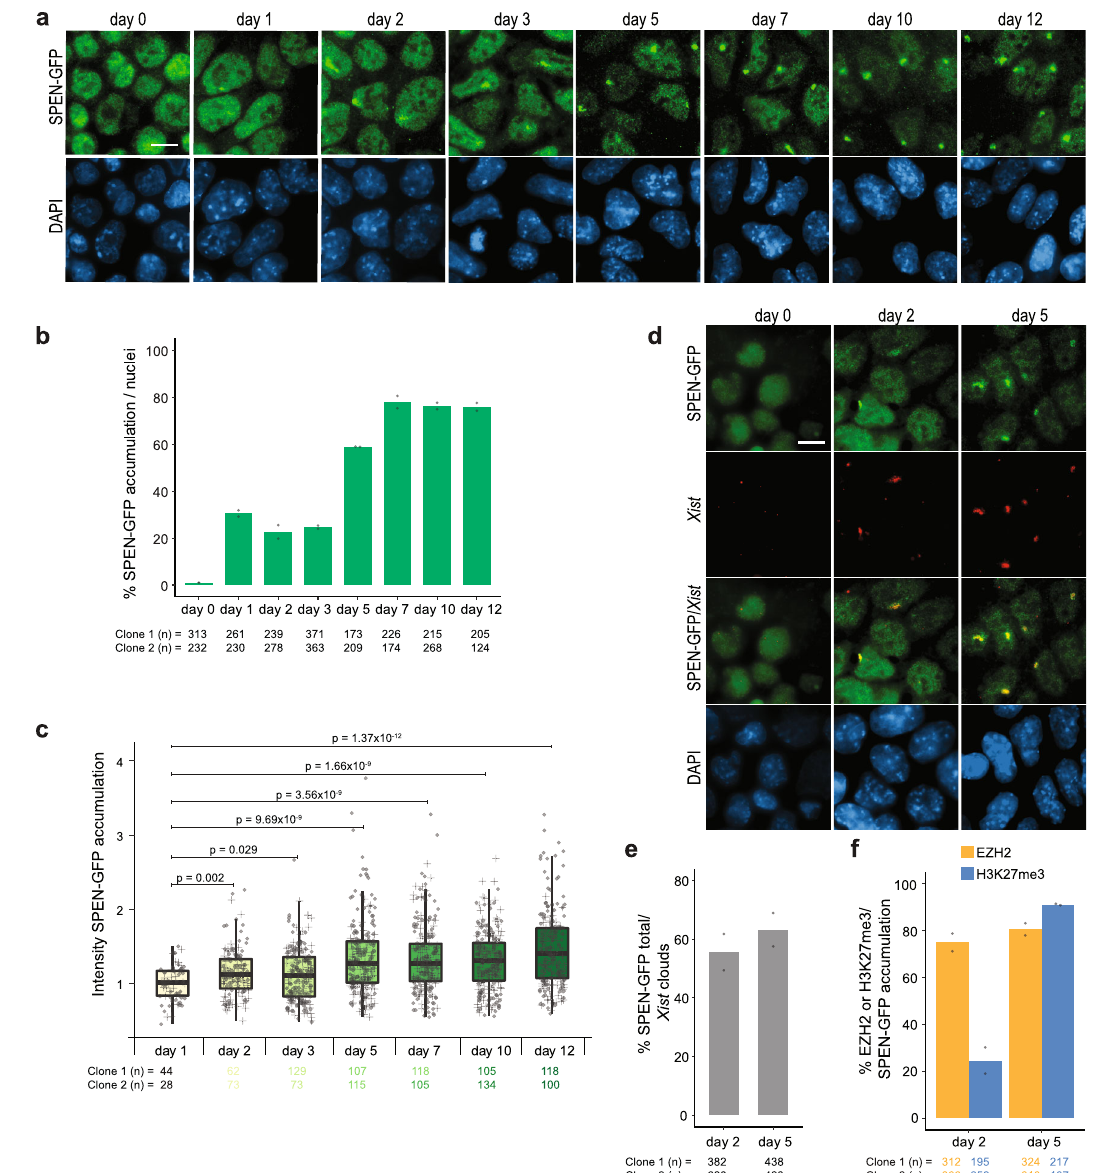
Fig. 3 SPEN colocalizes with the Xi chromosome very early during monolayer differentiation. a SPEN-GFP IF staining ( α GFP, green) at different time points of monolayer differentiation (day 0, 1, 2, 3, 5, 7, 10, and 12). DNA is stained with DAPI (blue). Scale bar: 10 µ m. b Quanti fi cation of ( a ), depicting the percentage of SPEN-GFP accumulation per nuclei at different time points of monolayer differentiation. Average percentage, n = 2 independent clones, the total number of counted nuclei per clone is indicated. c Boxplots illustrating the intensity of SPEN-GFP accumulations at different days of monolayer differentiation. The box plots display the median (central black line), the interquartile range (box limits) and the whiskers represent 1.5x of the interquartile range. All the data points are shown for two independent SPEN-GFP clones ( fi lled circles vs. crosses). Two-sided Mann – Whitney test corrected with Benjamini – Hochberg for multiple testing ( α < 0.05). The total number of studied nuclei per clone is indicated. d IF ( α GFP, green) combined with Xist RNA FISH (red) of SPEN-GFP lines at days 0, 2, and 5 of monolayer differentiation. DNA is stained with DAPI (blue). Scale bar: 10 µ m. e Percentage of nuclei with a Xist cloud that also presents SPEN accumulation. Average percentage, n = 2 independent clones, the total number of counted nuclei per clone is indicated. Calculated from the same data as for Supplementary Fig. 4d. f Percentage of nuclei with SPEN accumulation that also present EZH2 or H3K27me3 accumulation. Average percentage, n = 2 independent clones, the total number of counted nuclei per clone is indicated. Calculated from the same data as for Supplementary Fig.